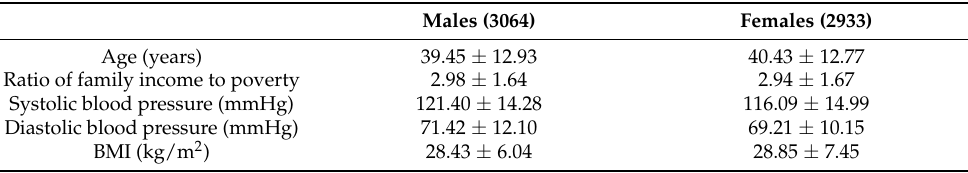
Table 1. Clinical demographic characteristics. Mean ± SD for continuous variables; Percentage (%) for categorical variables; BMI, body mass index; ApoB, apolipoprotein B; HDL, high-density lipoprotein; LDL, low-density lipoprotein; AA,